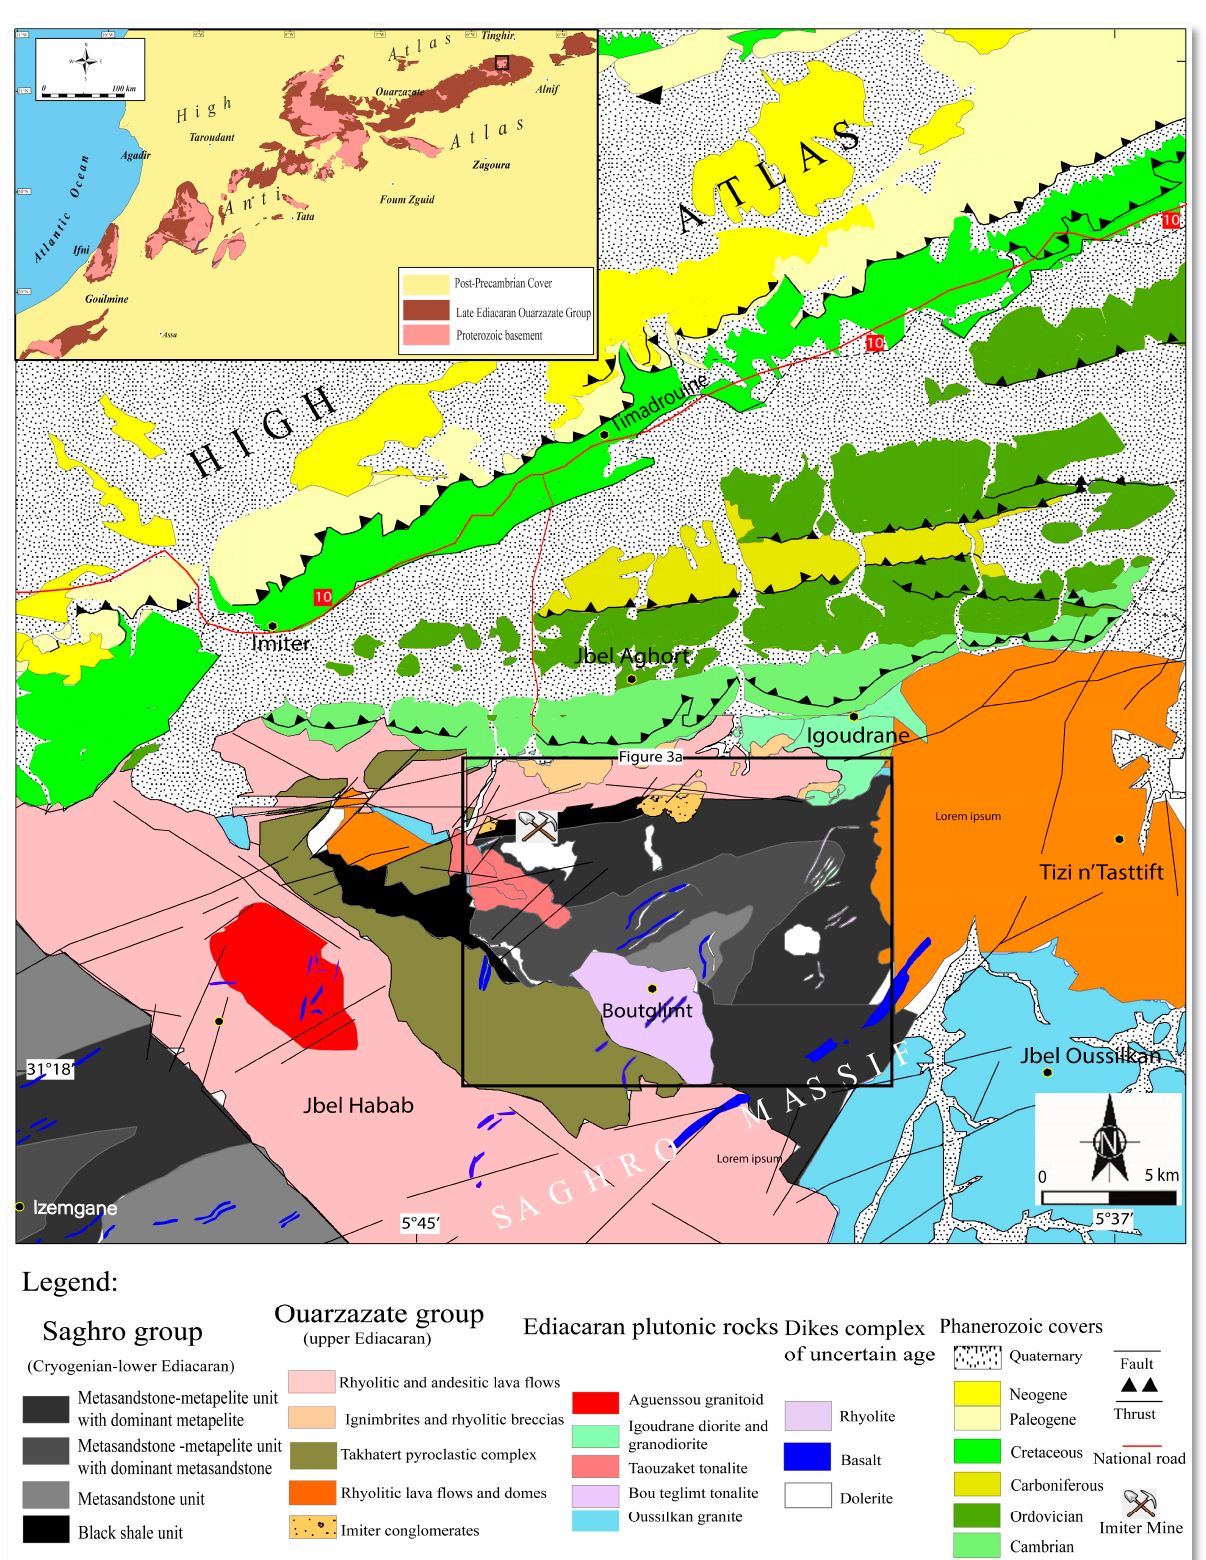
Figure 2. Simplified geological sketch map of the Imiter and Boumalne inliers and surrounding geological units (modified after [71,80]), the inset shows the location of Imiter area northeast of the Anti-Atlas.